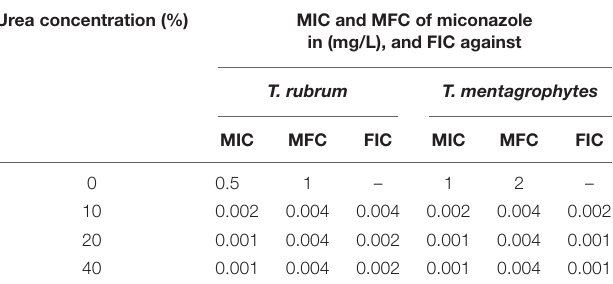
TABLE 1 | Minimum inhibitory, minimum fungicidal concentrations and fractional inhibitory concentrations of miconazole against T. rubrum and T. mentagrophytes in the absence and presence of different concentrations of